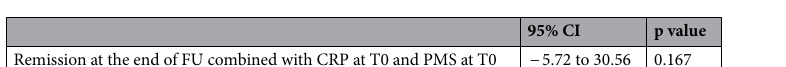
95% CI p value Remission at the end of FU combined with CRP at T0 and PMS at T0 − 5.72 to 30.56 Table 5. Multivariable logistic regression for CRP and PMS at T0 in the VDZ group (n = 19). Type: independent values (CRP and PMS at T0). CI confidence interval.